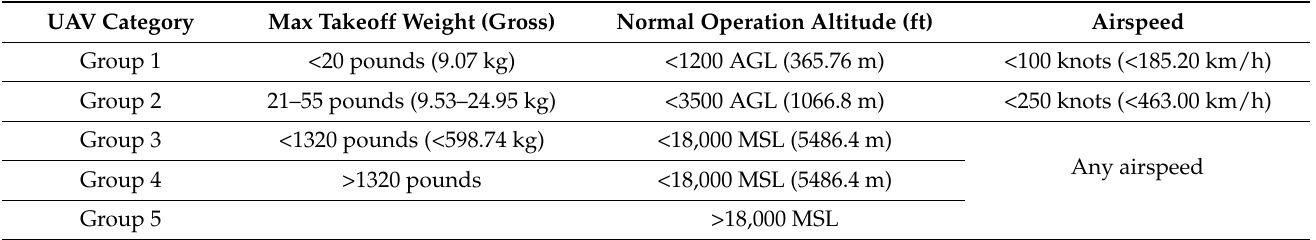
Table 1. UAV categorization used by the American Department of Defense [27].